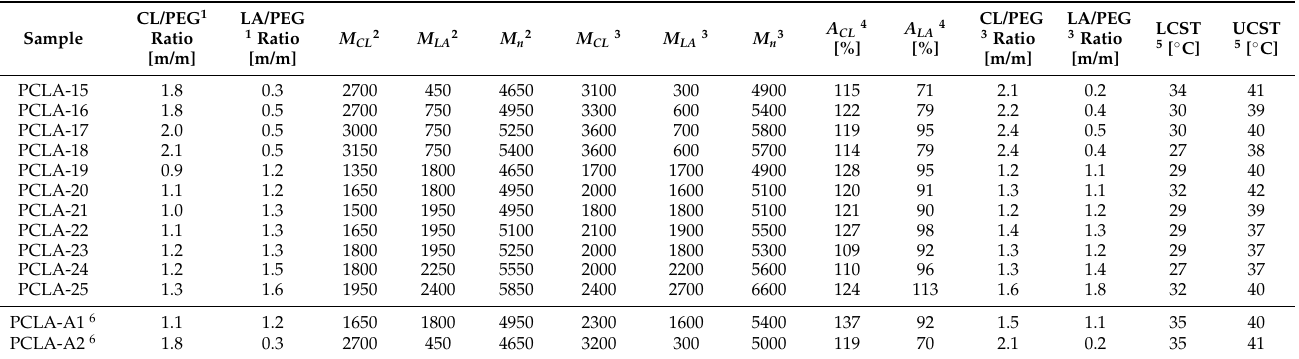
Table 2. The optimization of the PCLA